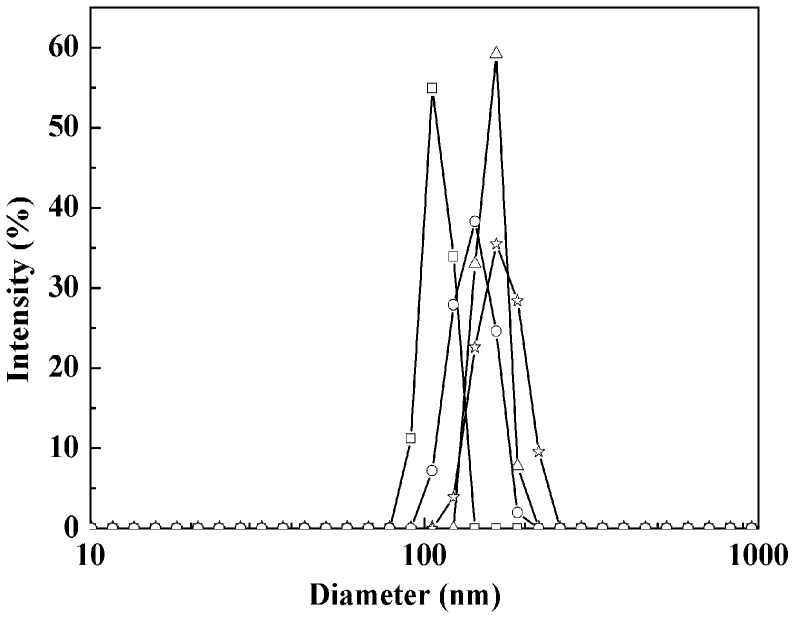
DLS hydrodynamic diameter distributions of nanoparticles.Fe3O4 (square), C3-Fe3O4 (circle), C8-Fe3O4 (triangle) and C18-Fe3O4 (star).